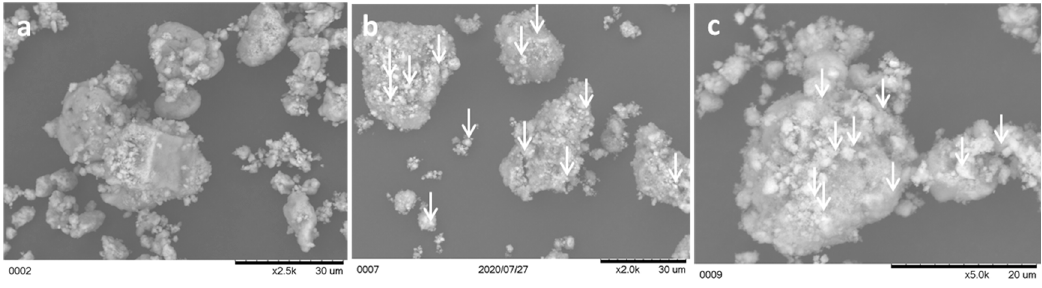
Figure 6. SEM images showing the morphology of calcined CZA-xHPW / TiO 2 hybrid catalysts: pristine CZA ( a ), CZA-1.4HPW / Ti ( b ), CZA-2.7HPW / Ti ( c ) (arrows indicate HPW / Ti particles).